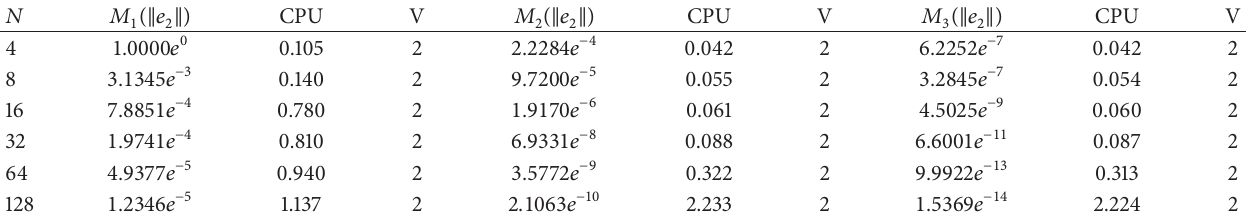
Table 1: Comparison of maximum absolute errors and CPU (seconds) for a Multigrid method with different schemes, for Example 1, ‖𝑒 2 ‖ , ℓ = 10 , and 𝑁 = 4, 8, 16, 32,64, 128 . 𝑁